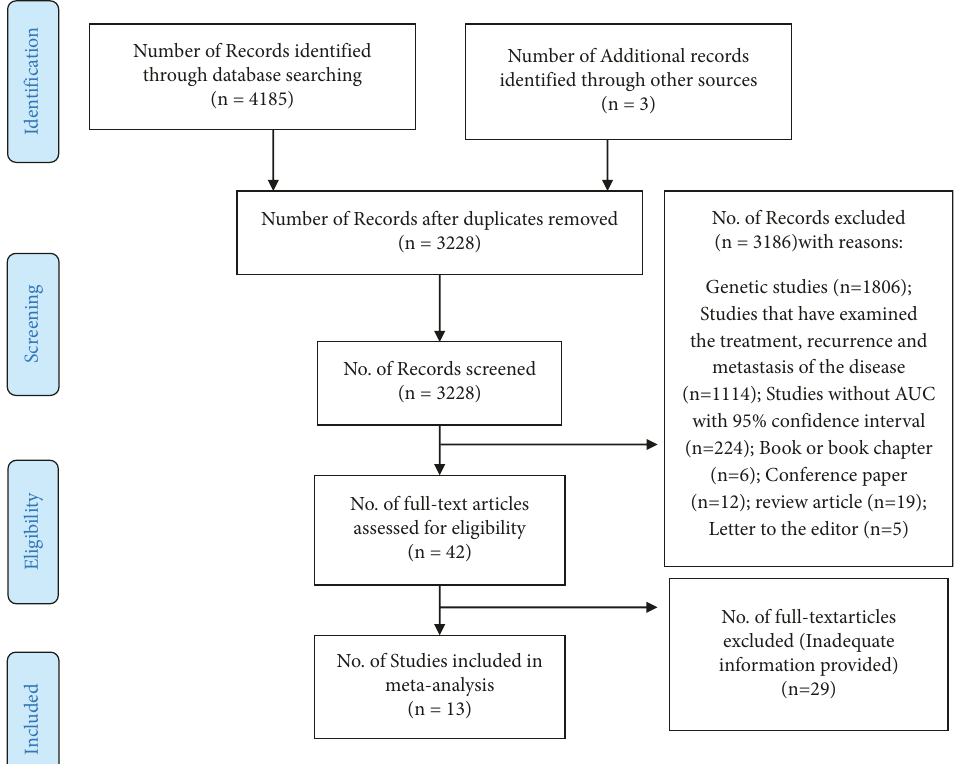
Figure 1: Flow of information through different steps of the systematic review and